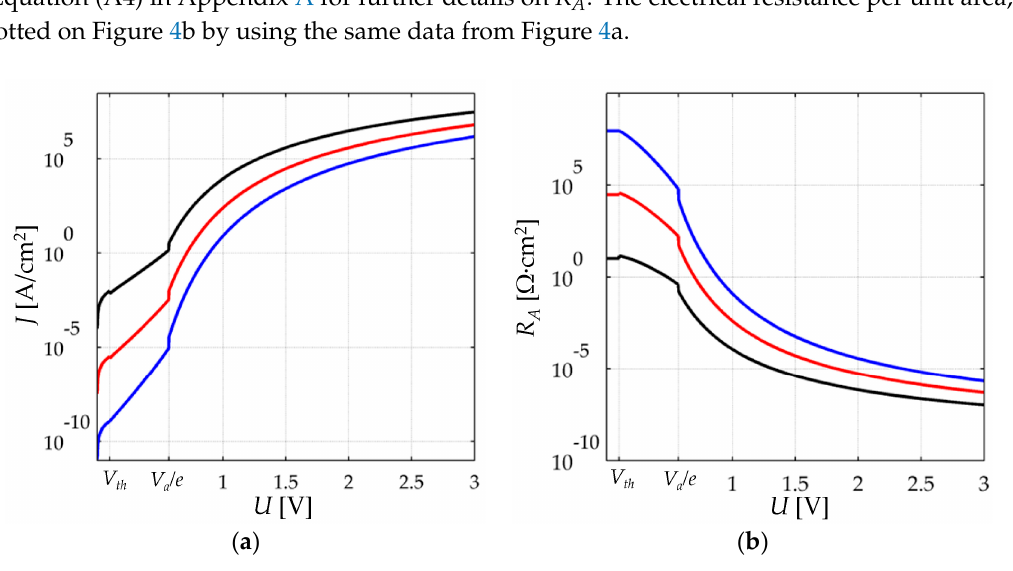
Figure 4. Simulated data for a thin insulating film as obtained from the Simmons’ theoretical equations [21] for V a = 0.57 eV, s = 6 nm (blue), s = 5 nm (red) and s = 4 nm (black). Incremental forces/stresses yield lower values of s . ( a ) Current density ( J ) as a function of the applied voltage ( U ); ( b ) Resistance per unit area ( R A ) as a function of U .